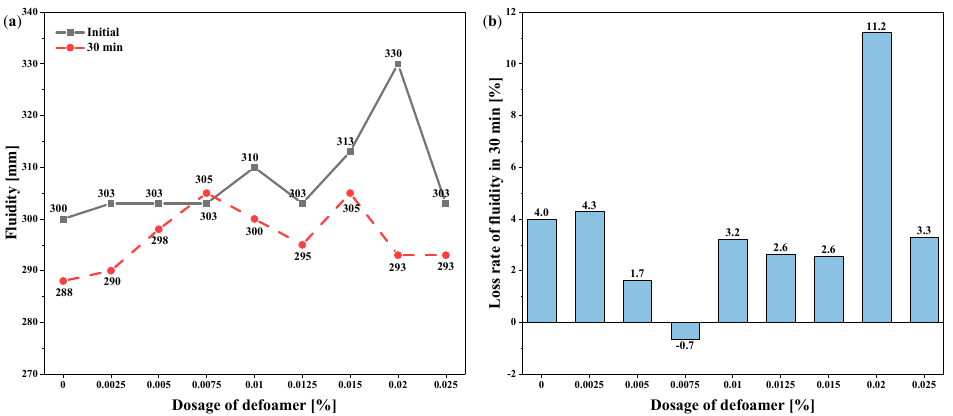
Figure 1. Influence of defoamer on the fluidity and loss rate of grouts at 30 min: ( a ) fluidity; ( b ) loss rate of fluidity at 30 min.